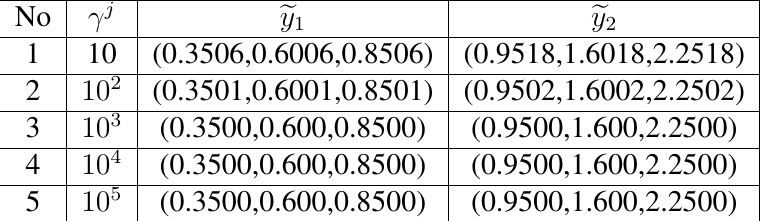
Table 2: Dual fuzzy linear programming problem solution ( i